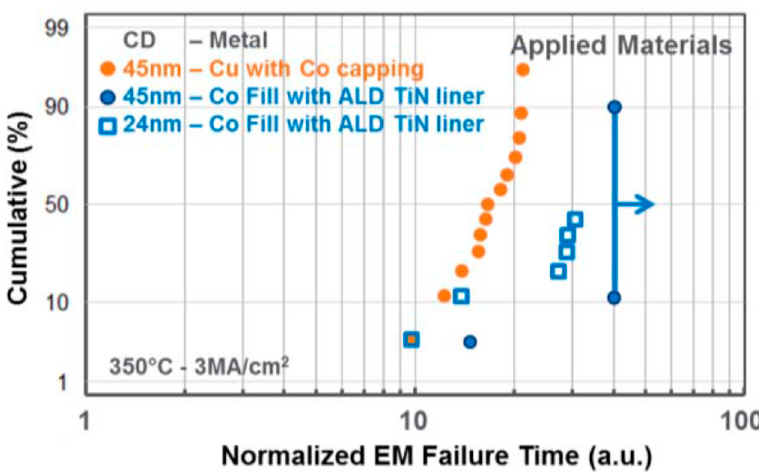
Figure 23. Performance of Co and Cu EM with 1-nm ALD TiN liner [139].